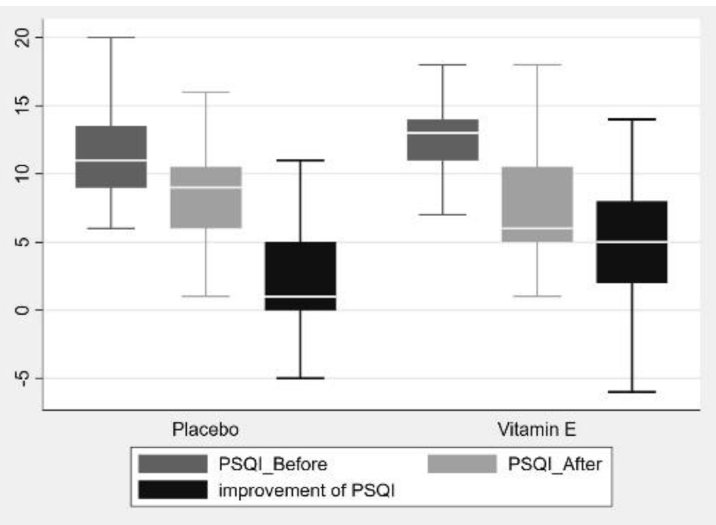
Figure 2. Boxplot of the PSQI score before and after intervention between the two groups. Table 3. Sedative drug use in each group.